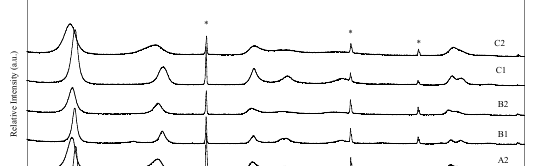
hydroxides at 20ºC. (A1- Mg/Al B1- Mg/Co/Al ; B2- Mg/Co/Al W20 C2- Mg/Ni/Al ) Crystalline phases: O- MgO, *- Si, N20 all others-LDH.